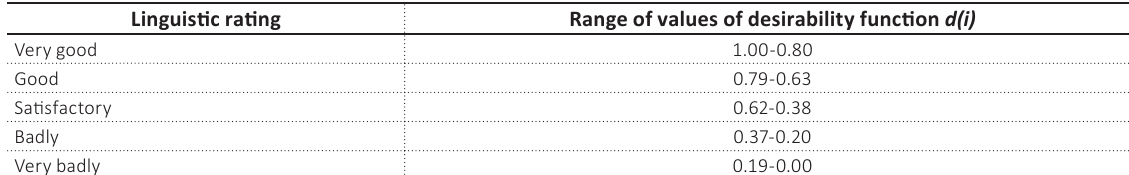
Table 3. Harrington’s desirability scale